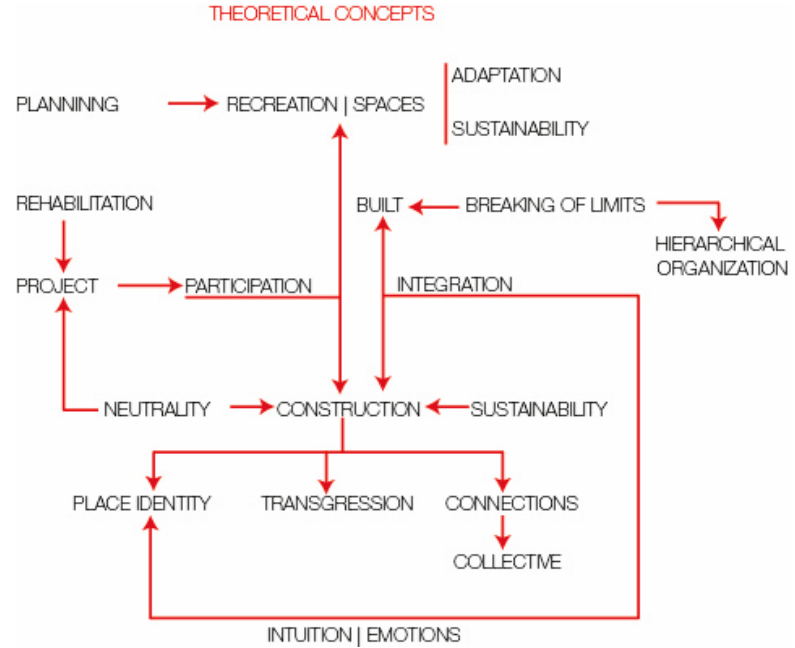
Figure 1. Synthesis of Pascuala Campos’s theoretical production (Authorship: AFC).